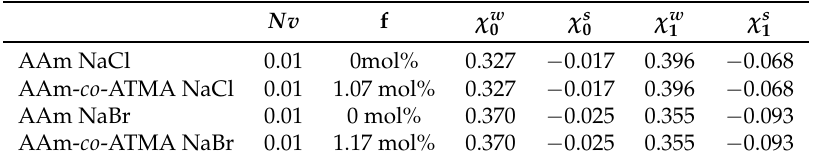
Table 2. Optimized model parameters assuming equal crosslinking densities in all